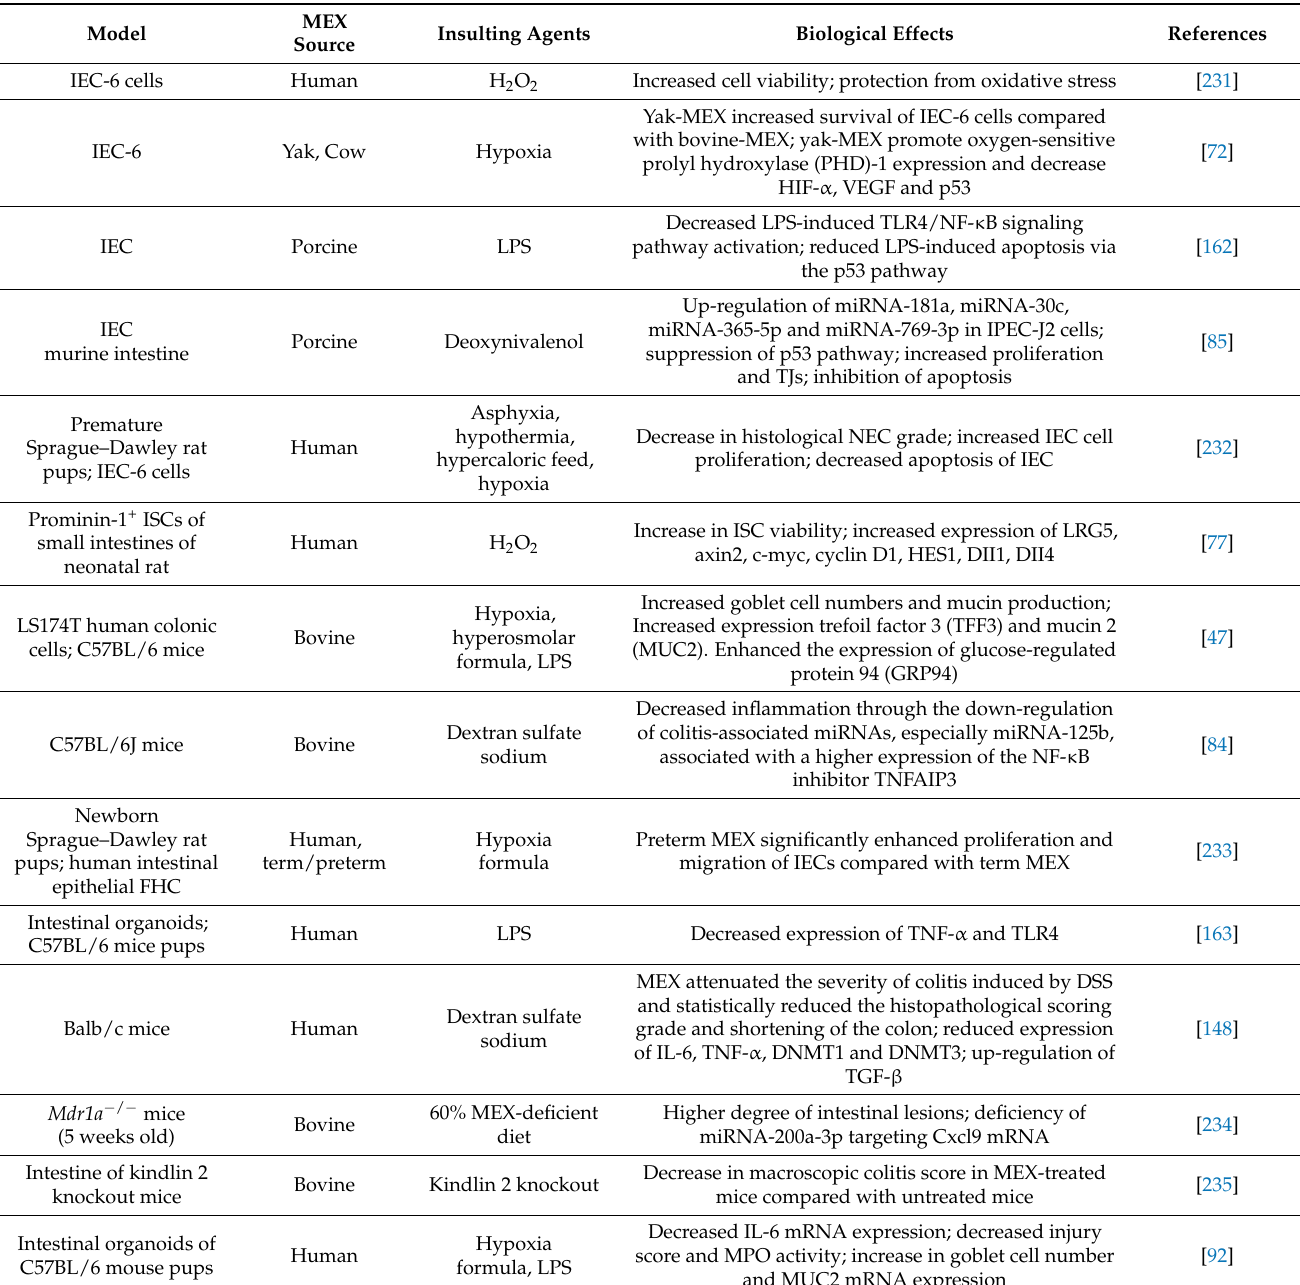
Table 1. Biological effects of milk-derived exosomes (MEX) in colitis and NEC